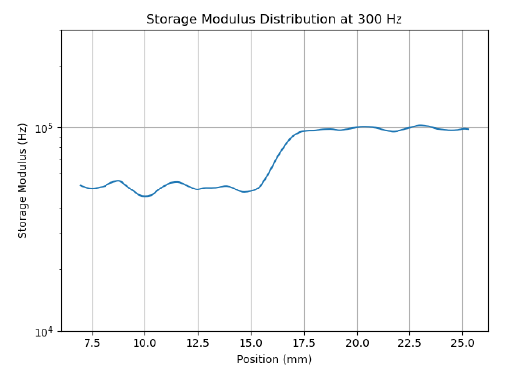
Fig. 6. Spatial distribution of storage modulus at 300Hz, 20 o